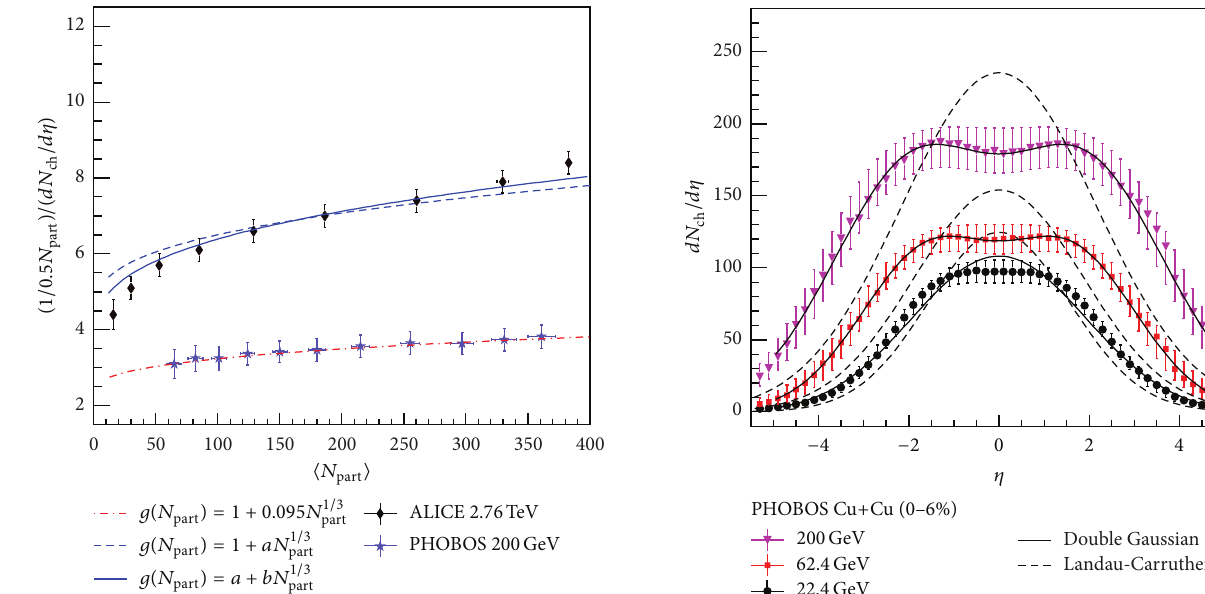
Figure 14: The charged particle multiplicity density distributions of Cu+Cu collisions at three different energies, fitted with double Gaussian function and Landau-Carruthers